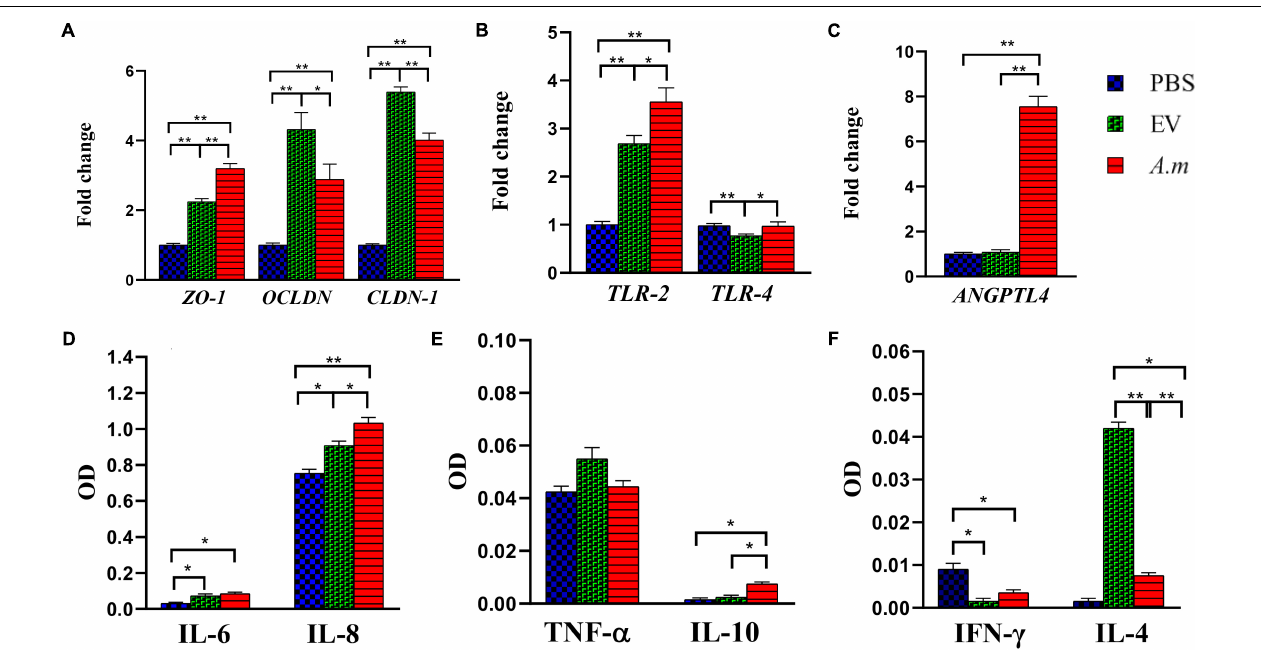
FIGURE 5 | The effect of A. muciniphila and its EVs on the study’s genes and cytokine secretion in the Caco-2 cell line. Caco-2 monolayers were treated with A. muciniphila (MOI 100 ) and EV concentration (10 µ g) for 24 h. The expression of genes: (A) ZO-1, OCLDN , and CLDN-1 ; (B) TLR-2 and TLR-4 ; and (C) ANGPTL4 . The levels of cytokines: (D) IL-6 and IL-8; (E) TNF- α and IL-10; and (F) IFN- γ and IL-4. Expression data are normalized using GAPDH as control gene. ∗ P < 0.05 and ∗∗ P < 0.01 were considered statistically significant,